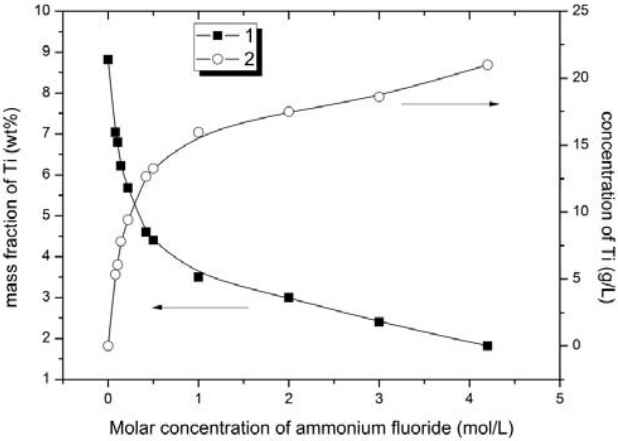
Figure 2. Titanium content in the solid and liquid phases vs. concentration of ammonium fluoride.